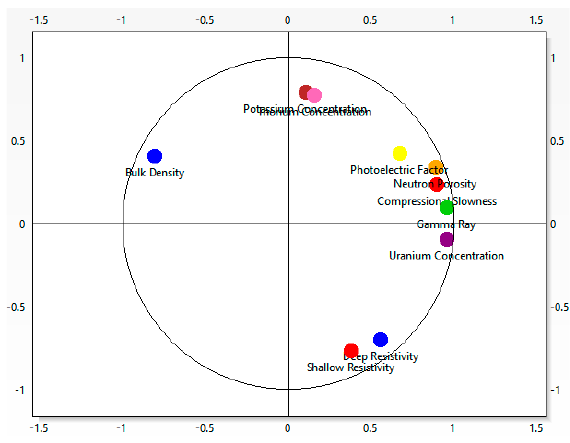
Figure 6. PCA analysis model of logging curve. Table 1. Correlation analysis table of each logging curve.